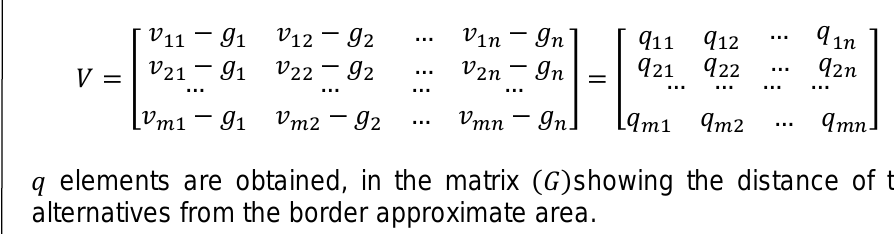
Table 14 – Matrix of the distances of alternatives from the BAA